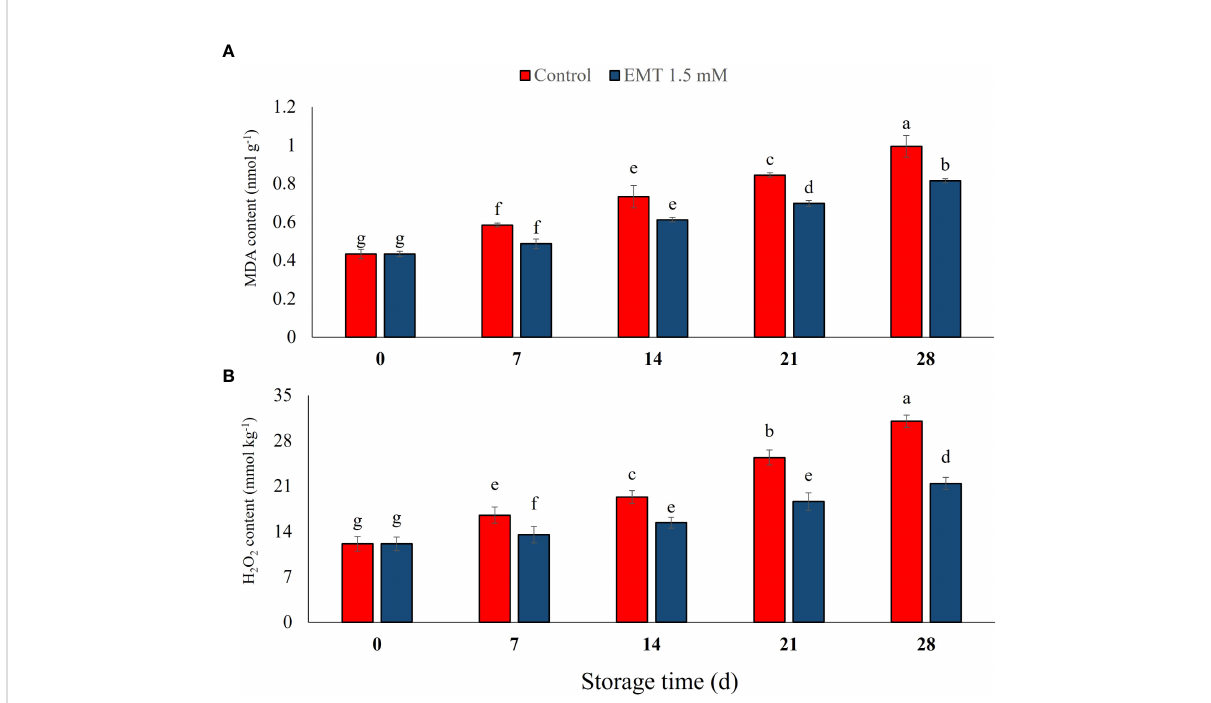
FIGURE 4 Effect of EMT treatment on MDA (A) and H 2 O 2 content (B) of papaya fruits during cold storage. Data collected from the mean of three replicates, and vertical bars indicate the standard error of the means. Mean values with different letters show signi fi cant differences, and those with the same letters show no statistical difference according to the least signi fi cant difference test ( P <